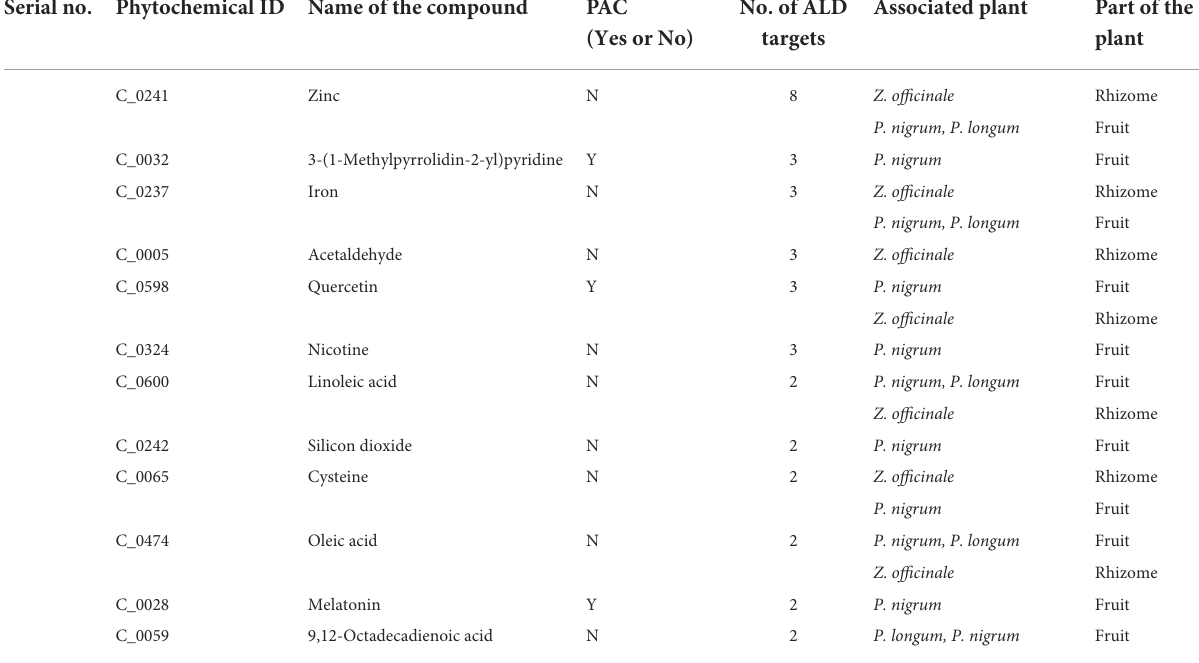
TABLE 1 The information of multi-targeting PCs, including PACs in managing ALD among the ALD-PT network. Serial no. Phytochemical ID Name of the